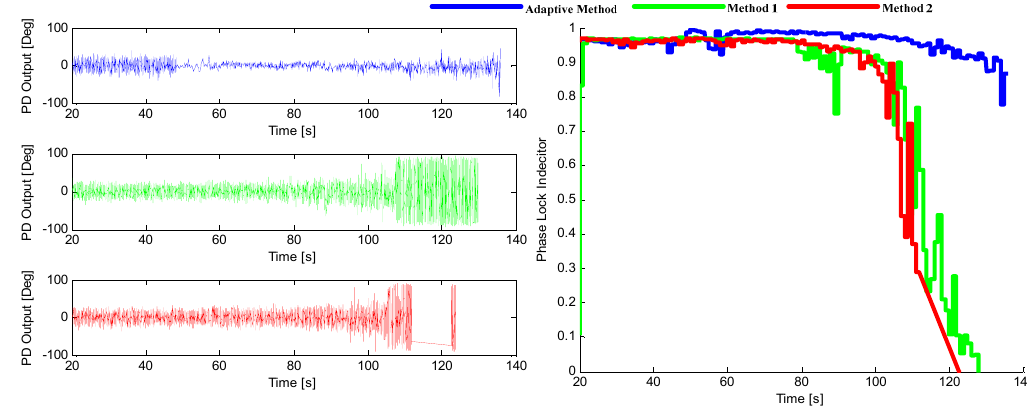
Figure 19. The output of PD ( left ) and the corresponding PLI ( right ) for SV29 in Trajectory 1. The root mean square (RMS) of three-dimensional position and velocity error is adopted for the navigation performance comparison in this paper. The position and velocity errors are shown in Figure 20. It can be seen that the adaptive tracking method has the best performance, and a same conclusion can be also drawn from Table 2, where the RMSs of the position and velocity errors are given. From the table, we can see that the velocity error is decreased by 37% and 40%, and the position error decreased by 24% and 17%.